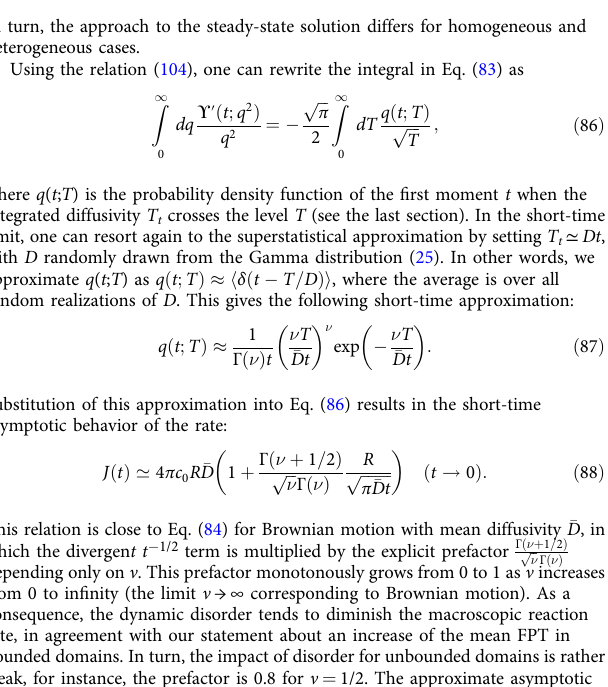
Fig. 6 The impact of dynamic disorder onto the distribution of fi rst-passage times for the exterior of a ball. The probability density function ρ ( t | r 0 ) of the fi rst-passage time to a perfectly reactive ball of radius R from the exterior space (with r R = 1.2) is shown by color lines for various combinations of 0 / dimensionless parameters ( μ , 1/ ν ) characterizing the disorder scale and strength: μ = στ / R and 1 = ν ¼ τσ 2 = (cid:1) D . Thick black line presents the probability density ρ hom ( t | r 0 ) from Eq. (77) for homogeneous diffusion with diffusivity (cid:1) D . a – c Three values of the disorder scale μ (0.1 ( a ); 1 ( b ); and 10 ( c )) and 64 values of the disorder strength 1/ ν in the logarithmic range between 10 − 1 and 10 1 . d – f Three values of the disorder strength 1/ ν (0.1 ( d ); 1 ( e ); and 10 ( f )) and 64 values of the disorder scale μ in the logarithmic range between 10 − 1 and 10 1 . Curves encoded by color, ranging from dark blue (10 − 1 ) to dark red (10 1 ), as shown by relation (88) does not depend on the disorder scale μ . According to the superstatistical approximation, this relation is actually the lower bound for the fl ux J ( t ) corresponding to the limit τ → 0 or, equivalently , μ → ∞ . In turn, the exact expression (84) for Brownian motion corresponds to the limit μ → 0 and thus is